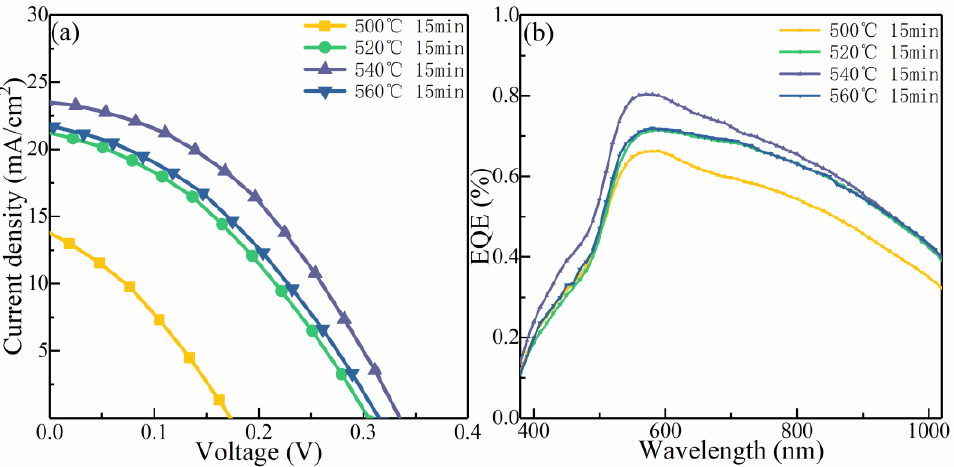
Figure 9. ( a ) Current–voltage characteristics of the CMZTSSe-based solar cells synthesized using the CMZTSSe absorber layer annealed at the temperatures of 500 ◦ C, 520 ◦ C, 540 ◦ C, and 560 ◦ C. ( b ) EQE spectra of the corresponding CMZTSSe-based solar cells. Table 3. The performance parameters of the CMZTSSe film solar cells. Temperature ( ◦